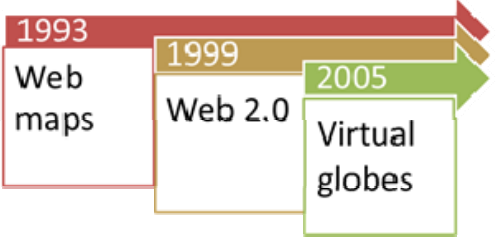
Figure 2: Framework of web mapping